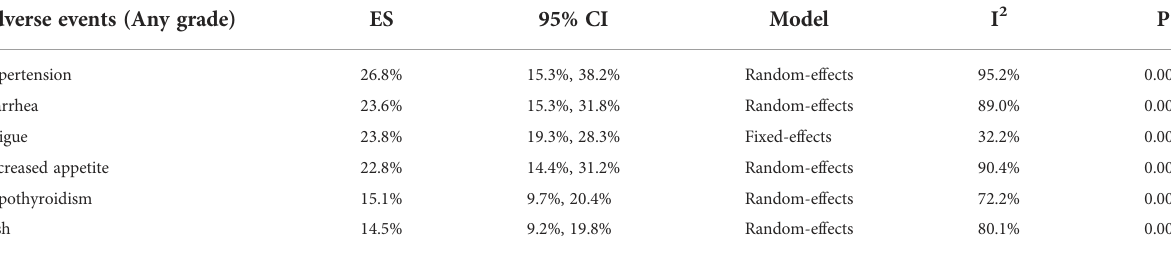
TABLE 2 The common adverse events of immune checkpoint inhibitors combined with antiangiogenic drugs in the treatment of HCC. Adverse events (Any